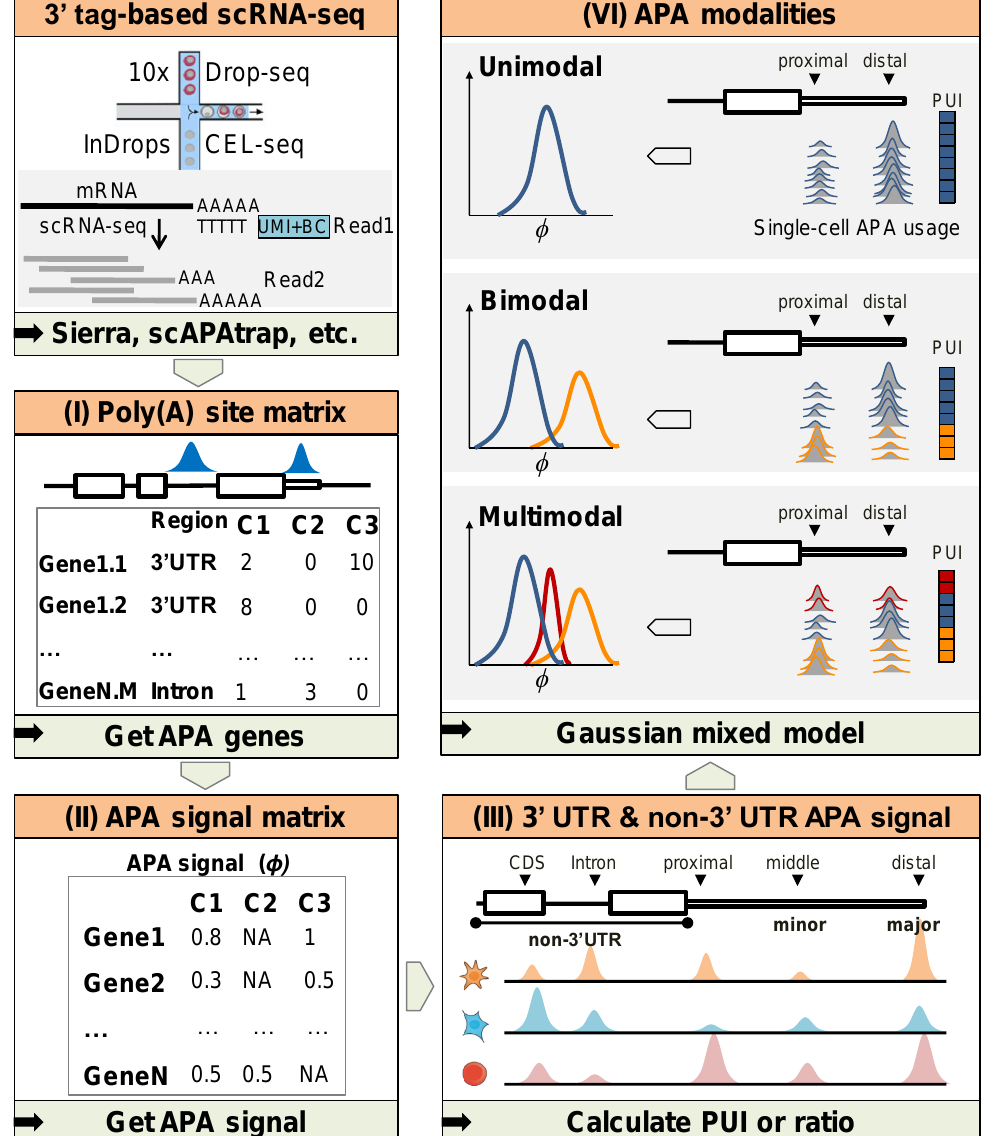
Figure 1. The flow chart of APA modality recognition using scAPAmod. (I) Poly(A) sites were identi- fied and quantified from raw 3 (cid:48) tag-based scRNA-seq data using existing tools. (II) The poly(A) site matrix was transformed to an APA signal matrix, where each gene or each APA site was represented by the poly(A) usage index (PUI) or ratio. (III) PUI or ratio of 3 (cid:48) UTR APA sites and non-3 (cid:48) UTR APA sites could be calculated for each gene or poly(A) site. (VI) Given the PUI or ratio values for a gene or an APA site in a cell population, the APA modality could be inferred by the Gaussian mixed